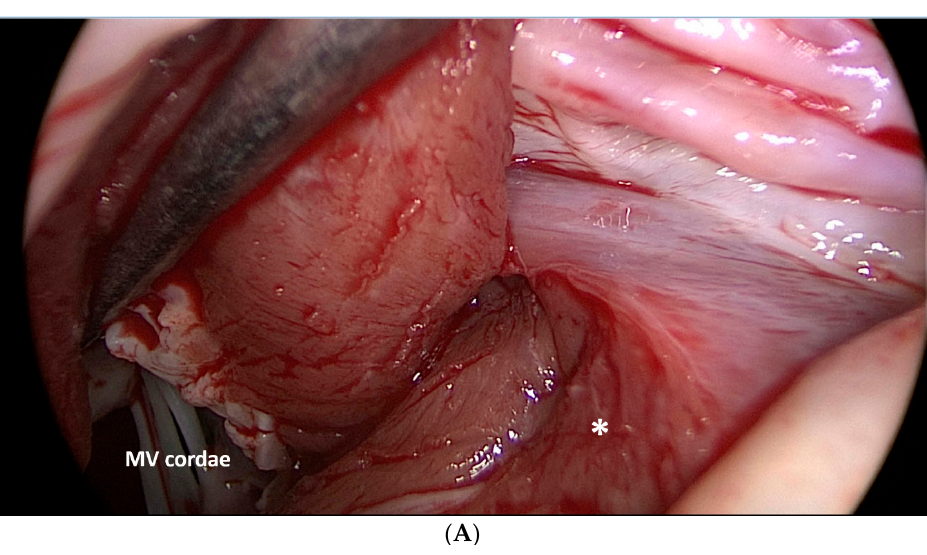
( B ) Figure 6. Surgical myectomy ( * ) was performed starting at the nadir of the right coronary sinus, and extended apically to achieve the exposure of the papillary muscles. MV: mitral valve ( A ). Surgical view of the diseased mitral valve secondary cordae (*) and papillary muscles (**) after myectomy. It is noteworthy that the bases of the papillary muscles are now visible ( B ). Ferrazi et al. have demonstrated that surgical treatment addressing septal hypertro- phy and valvular defects is effective in decreasing LVOTO, thus relieving HF symptoms while also avoiding later MV replacement [74]. A prospective randomized study found that SM with concomitant subvalvular inter- vention was superior in terms of abolishing LVOTO and improving MR as compared to SM alone in patients with subvalvular pathology [80]. Performing SM with a concomitant subvalvular procedure is a safe and efficacious operative strategy. Preoperative echocardiograms must be carefully evaluated to deter- mine if subvalvular morphology requires intervention.